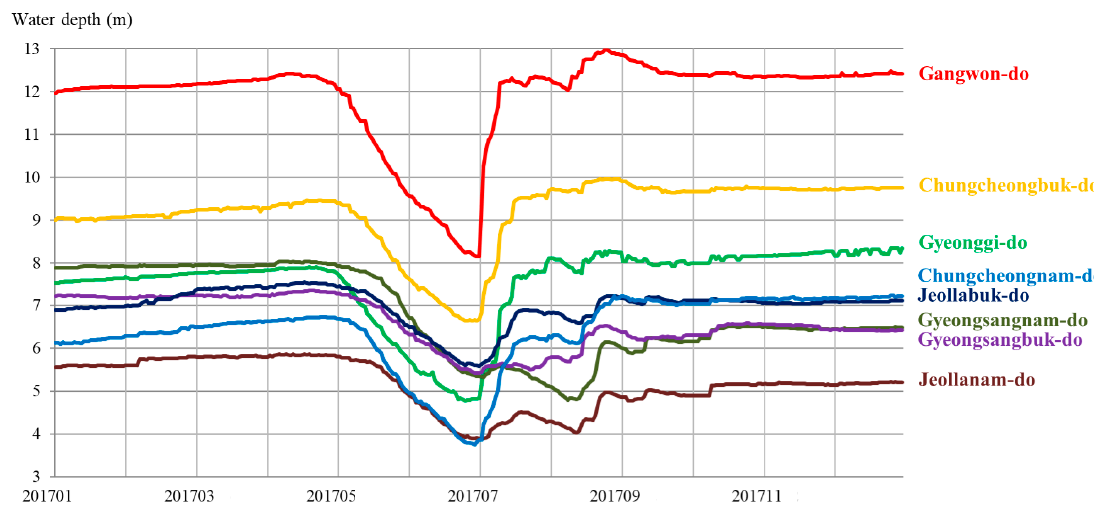
Figure 7. The variation of mean water depth over one year for reservoirs of each province.